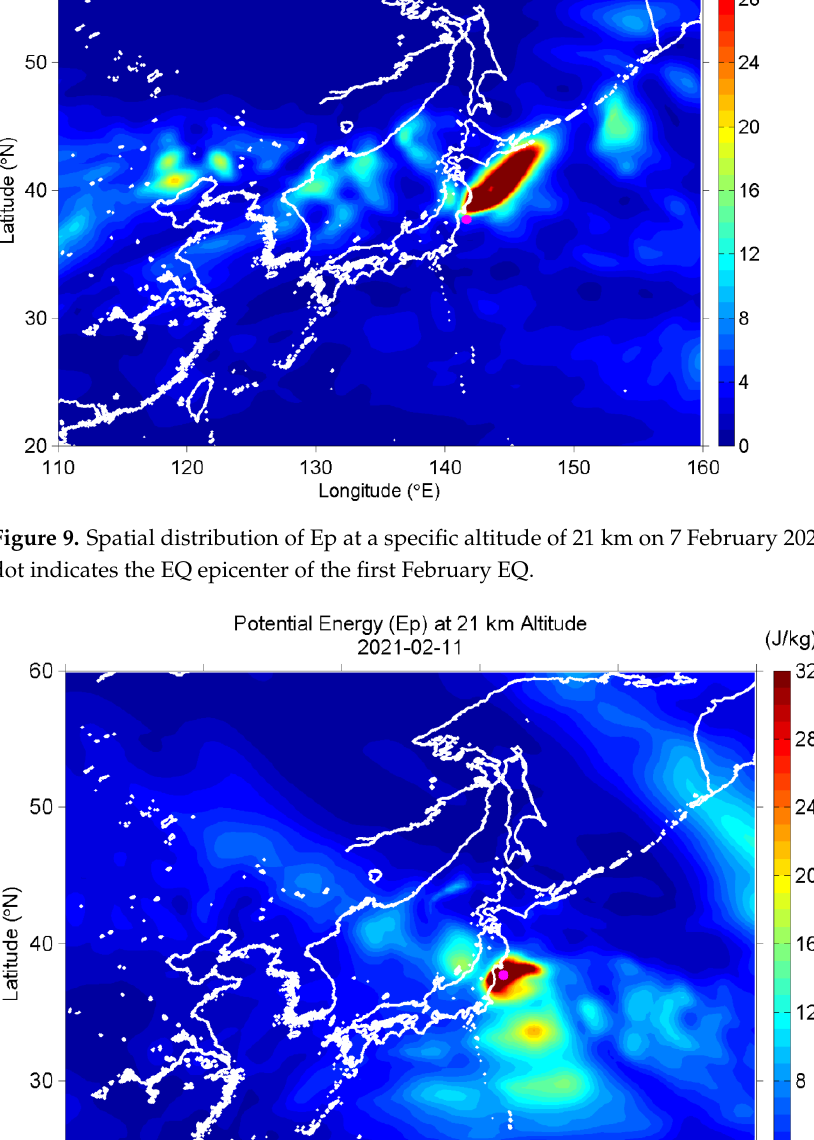
Figure 8. Temporal evolution of altitude profile of potential energy Ep over the epicenter. The ver- tical magenta line indicates the occurrence time of the first EQ. The red and blue arrows at the bot- tom of the figure indicate the passing of several weather systems, and the brown rectangle indicates a possible precursor to the first EQ.